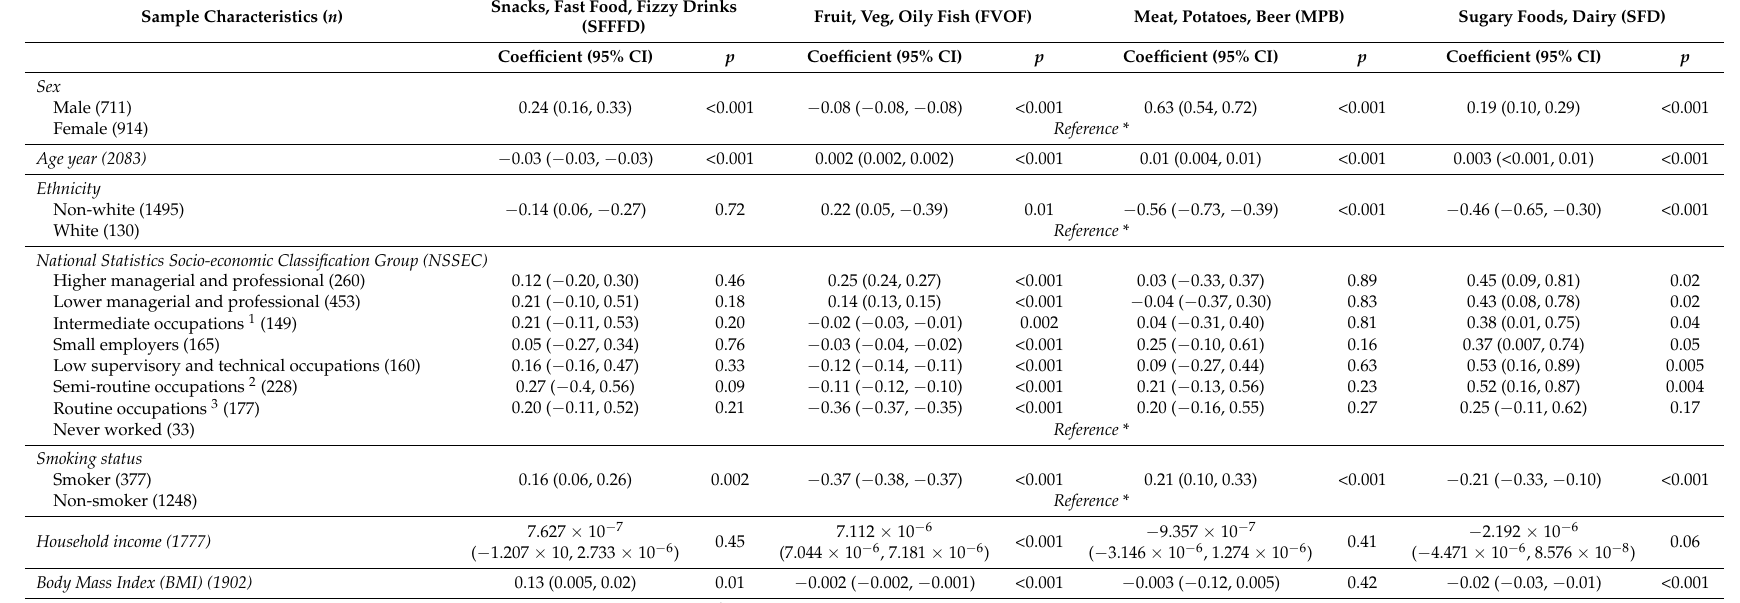
Table 5. Main effects (95% confidence interval (CI)) of each dietary pattern for sociodemographic characteristics and lifestyle